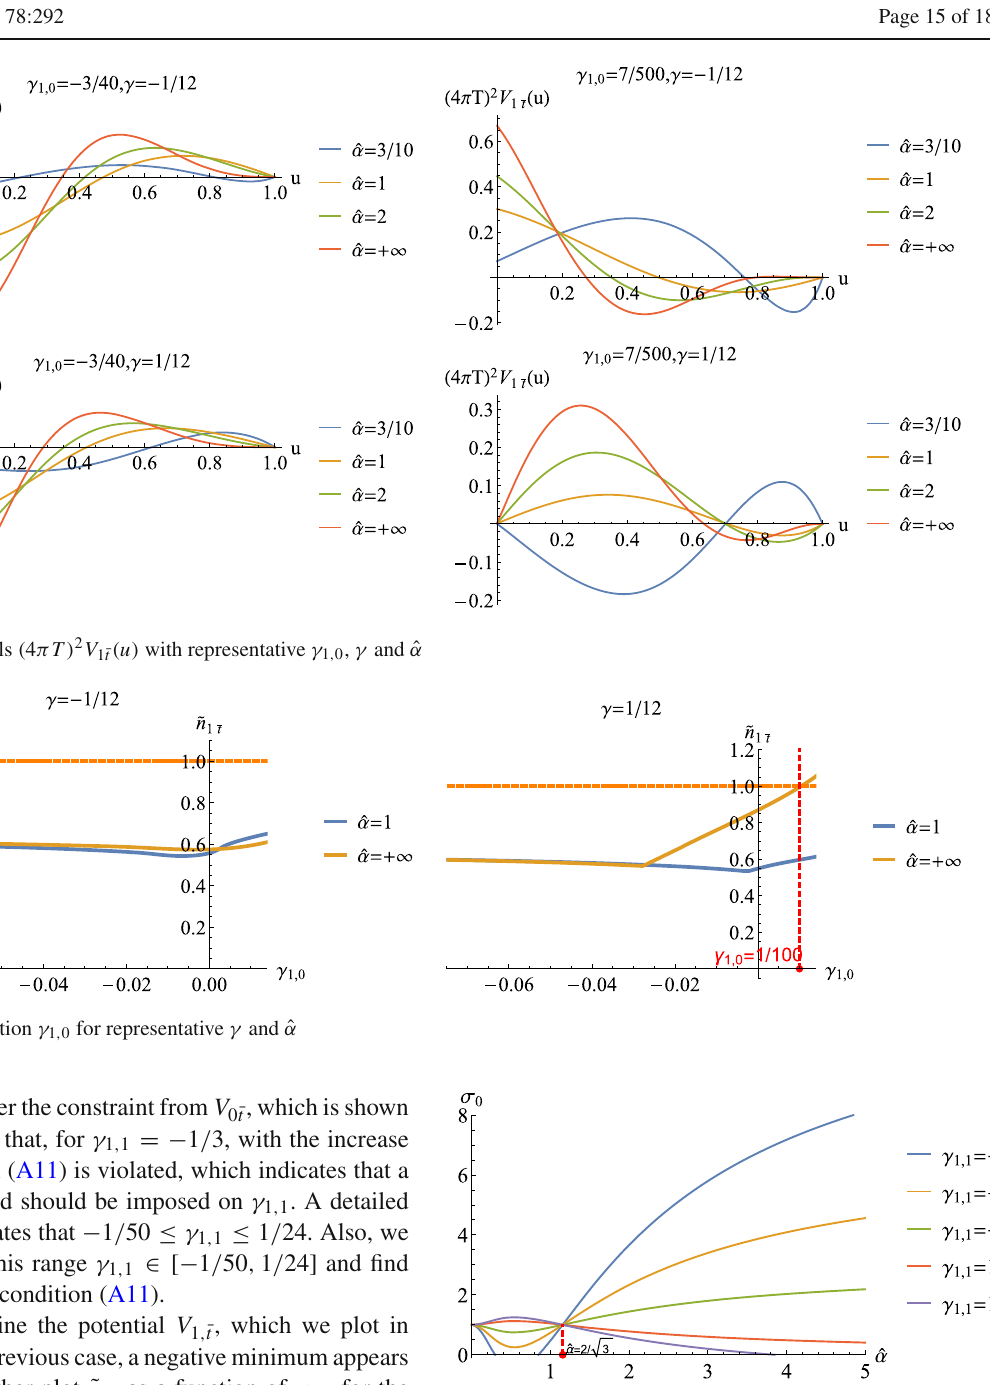
Fig. 23 The DC conductivity as a function of ˆ α when only γ 1 , 1 is turned